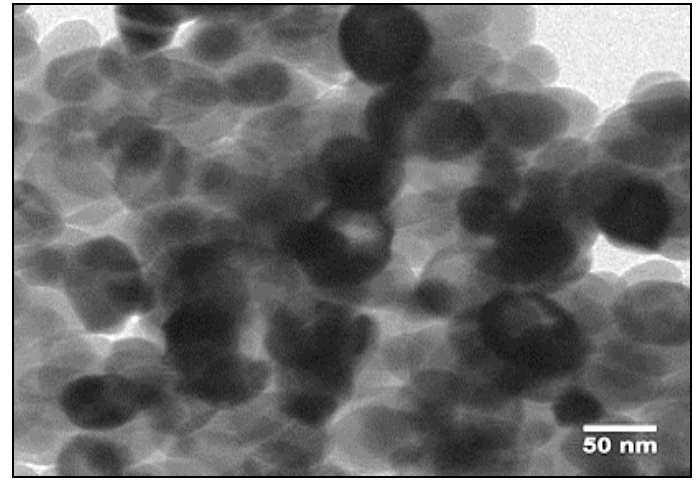
Figure 4. HRTEM Image of ZnFe 2 O 4 NPs.